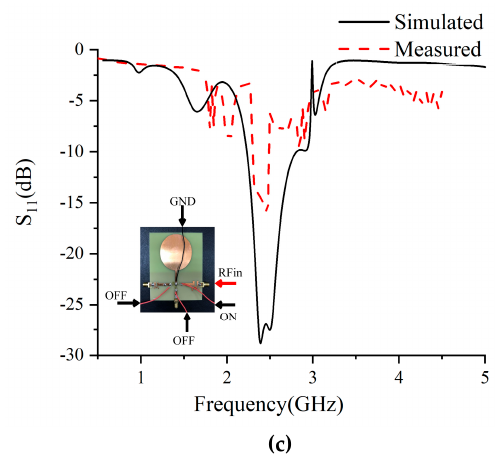
Figure 7. Summary of the S 11 of the reconfigurable antenna: ( a ) UWB state (D1 on, D2 and D3 off); ( b ) 3.5 GHz narrowband (D2 on, D1 and D3 off); and ( c ) 2.4 GHz narrowband (D3 on, D1 and D2 off).